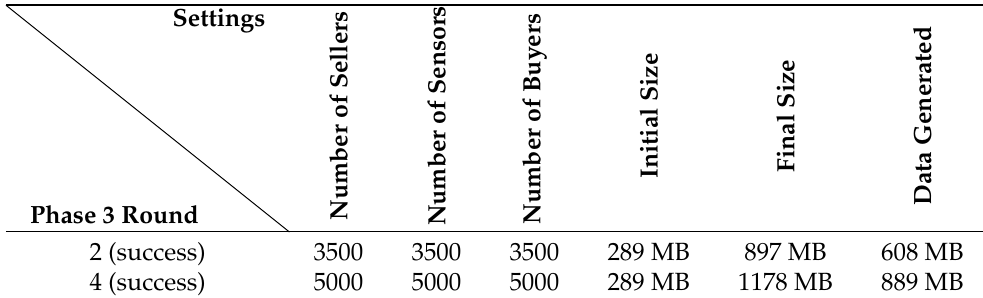
Table 5. Orderer data generation in Phase